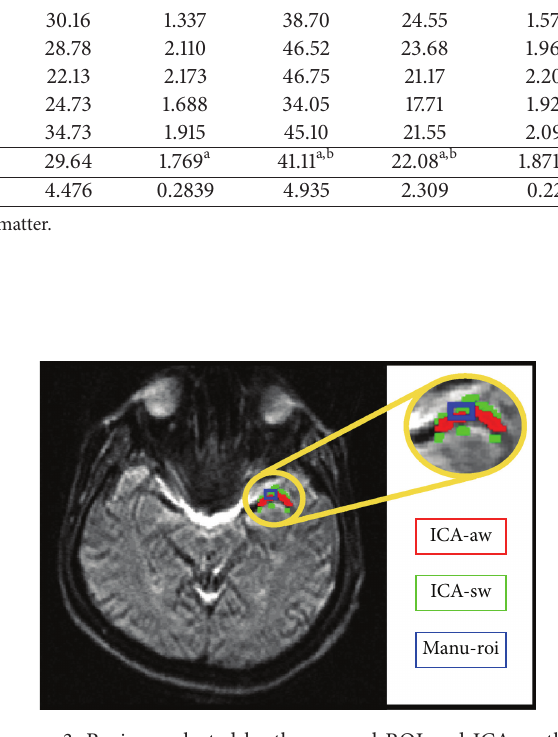
Figure 3: Regions selected by the manual ROI and ICA method (blue: manual selection; red and green: artery and its surrounding tissue selected by